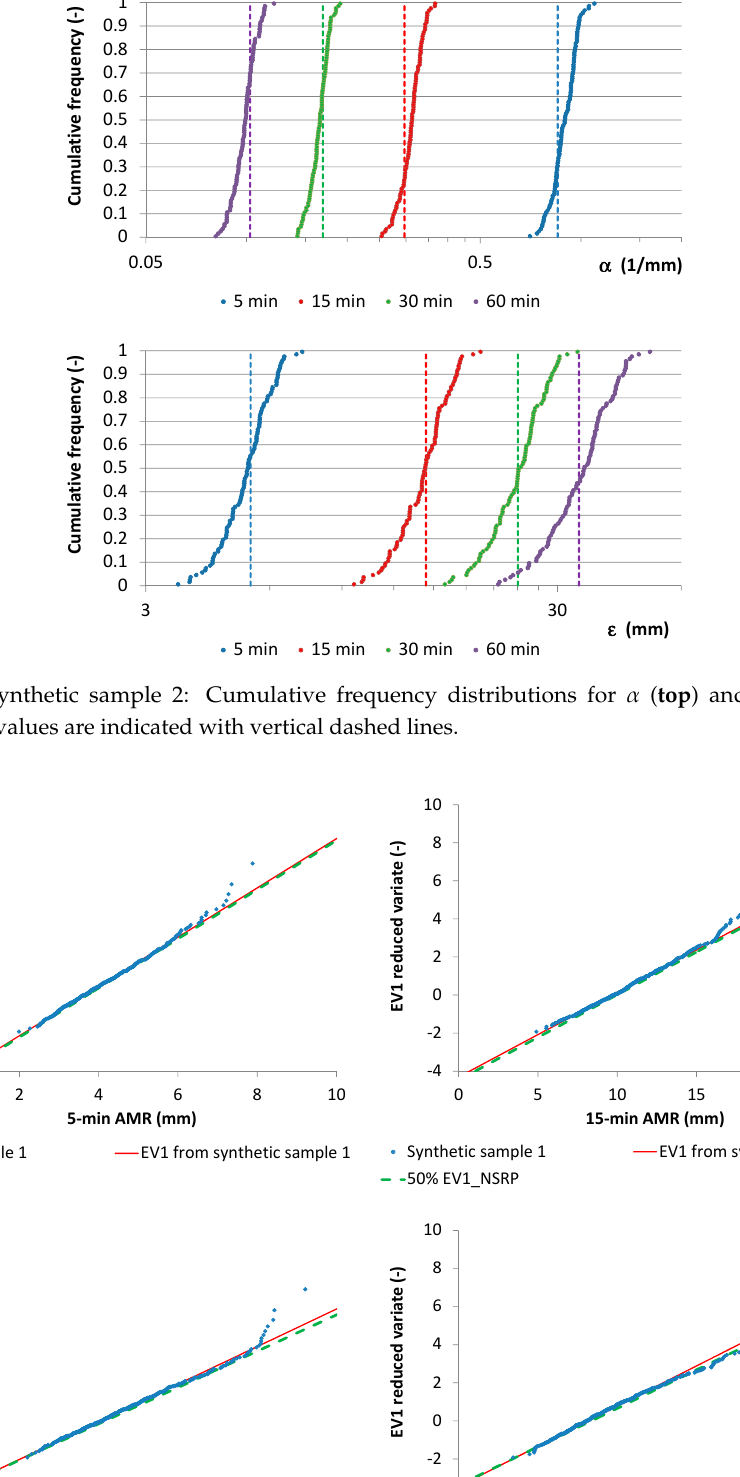
Figure 7. Synthetic sample 1: Cumulative frequency distributions for starting values are indicated with vertical dashed lines.